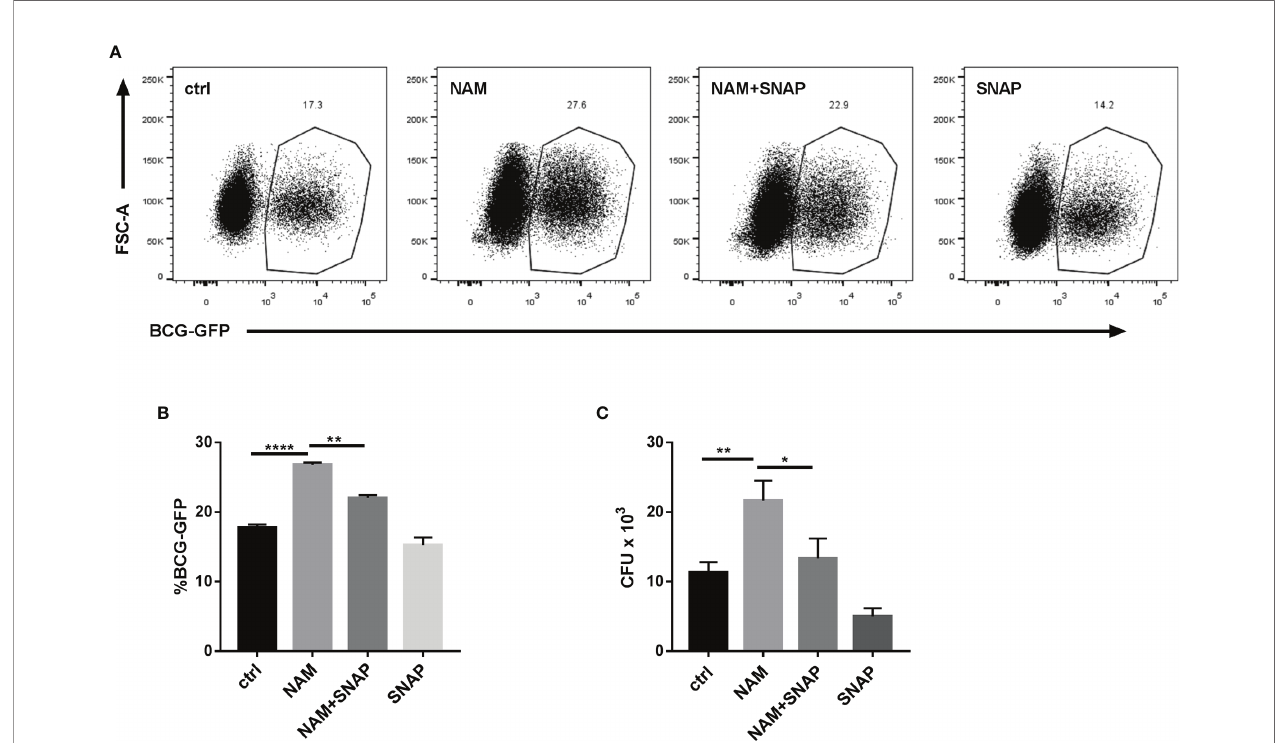
FIGURE 5 | Nitric oxide (NO) donor SNAP abrogates the NAM-induced increase in Mycobacteria burden in Raw264.7 cells. (A, B) Raw264.7 cells were pretreated with NAM (10 mM) and/or SNAP (200 m M) 24 h before infection with BCG-GFP (MOI 10:1) and were then analyzed by fl ow cytometry 24 h after infection. Representative fl ow cytometry images (A) were recorded and the percentage of BCG-GFP-positive Raw264.7 cells (B) were calculated by Flow Jo software. (C) Colony-forming unit (CFU) counts from Raw264.7 cells treated with NAM (10 mM) and/or SNAP (200 m M) 48h after infection. Data represent means ± SD for three independent experiments. One way ANOVA was performed in (B, C) . *p < 0.05; **p < 0.01; ****p<